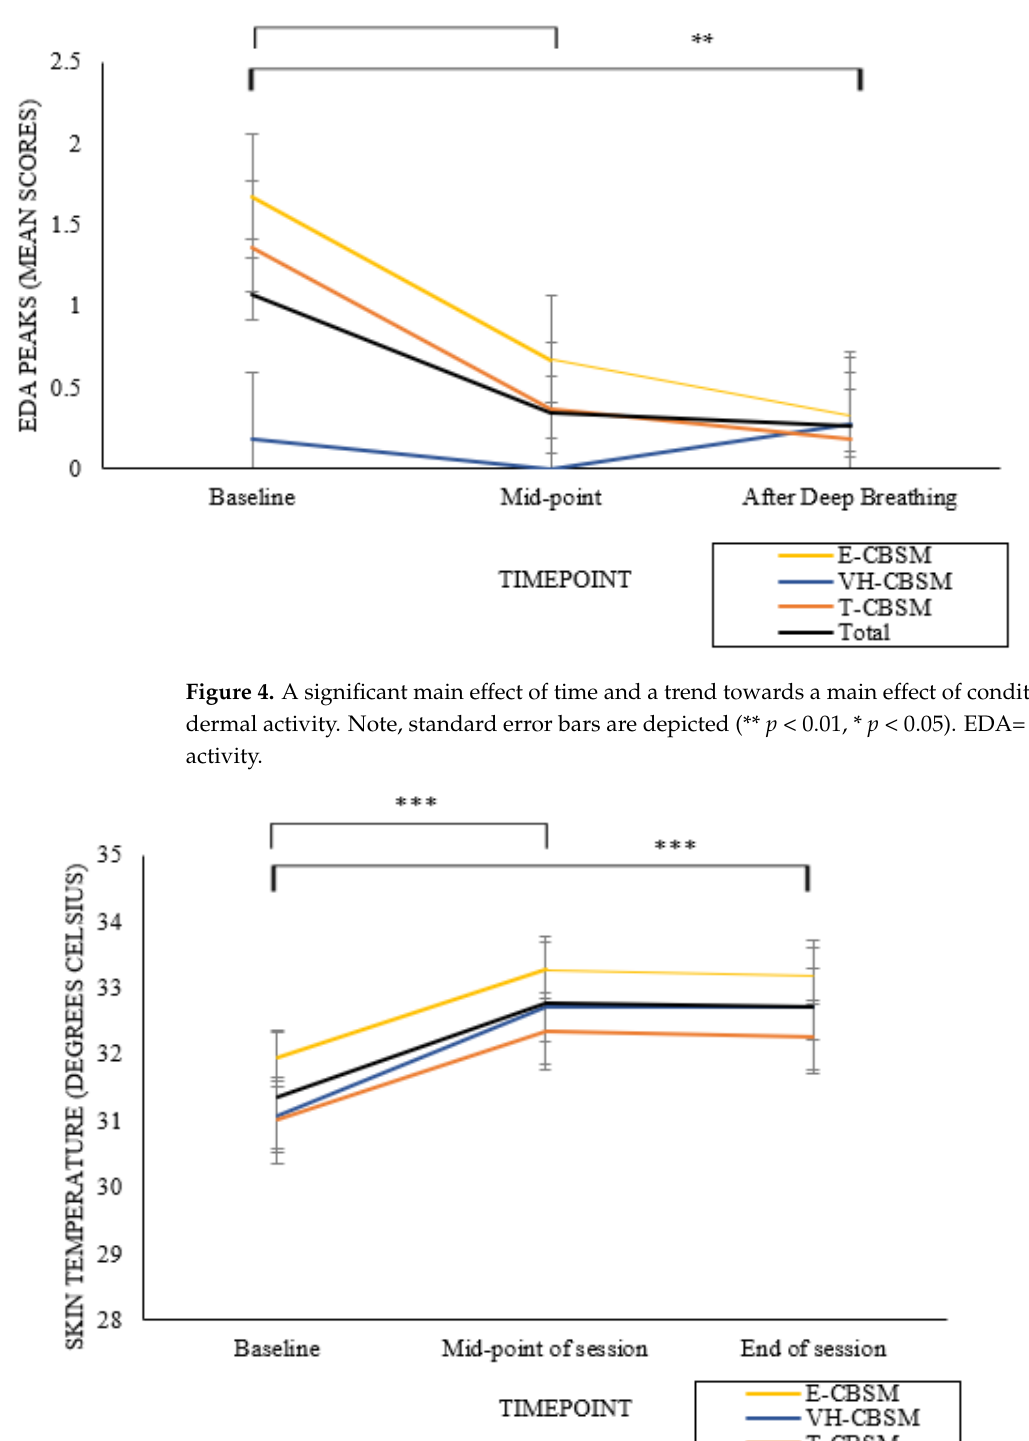
Figure 4. A significant main effect of time and a trend towards a main effect of condition on electrodermal activity. Note, standard error bars are depicted (** p < 0.01, * p < 0.05). EDA= electrodermal activity.